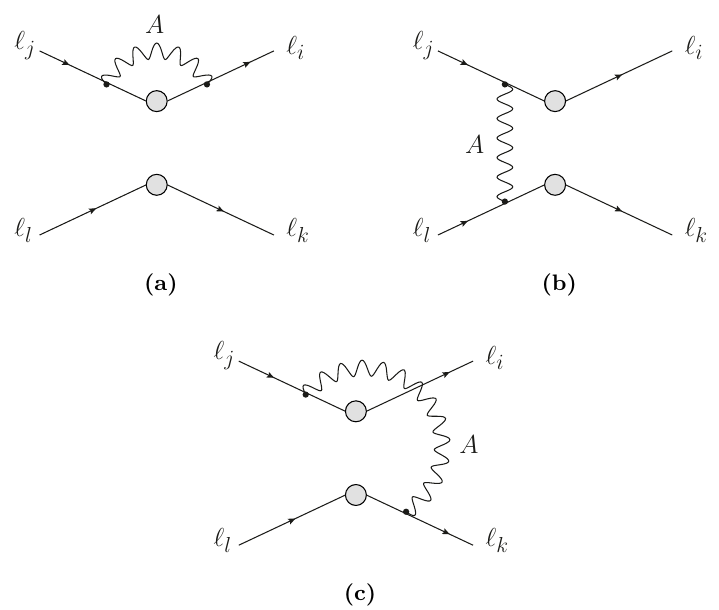
Figure 14. 1-loop QED corrections generating mixing among four-lepton